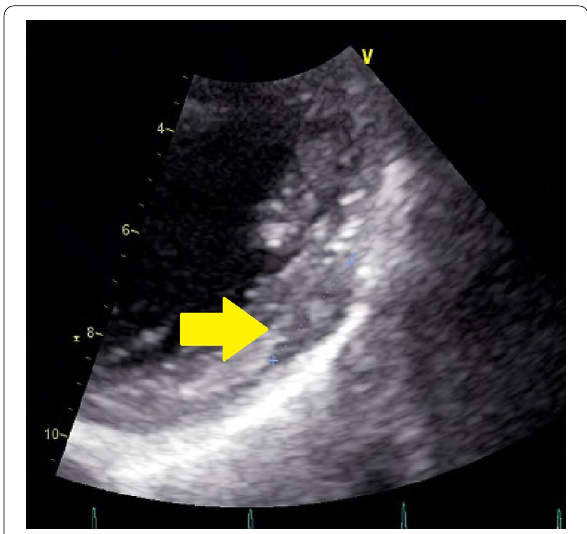
Fig. 1 Cardiac echography showing a tumor with a 12-mm diameter in the wall of the left ventricle (arrow)